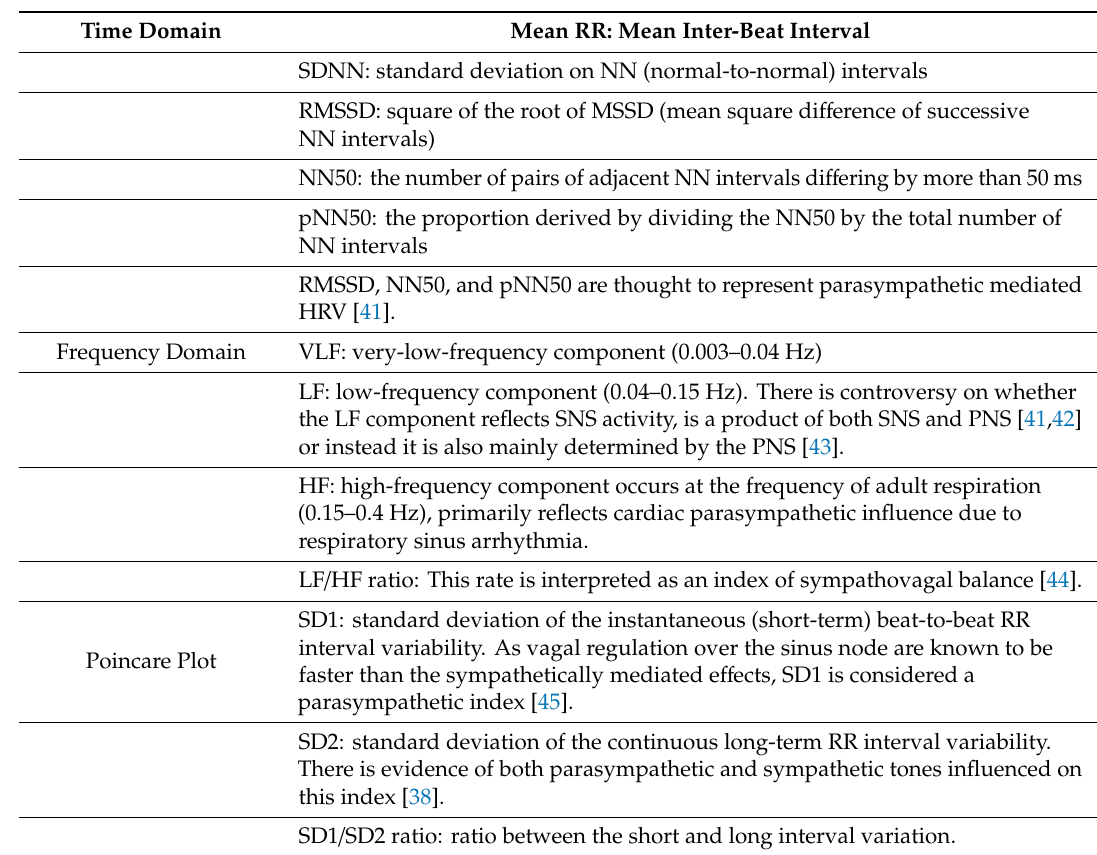
Table 1. Heart rate variability